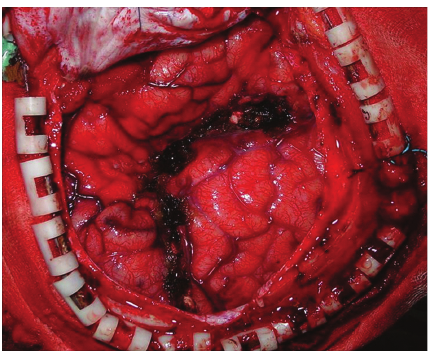
Figure 2: Intraoperative photograph of peri-insular posterior quadrantectomy (PIPQ) showing the line of